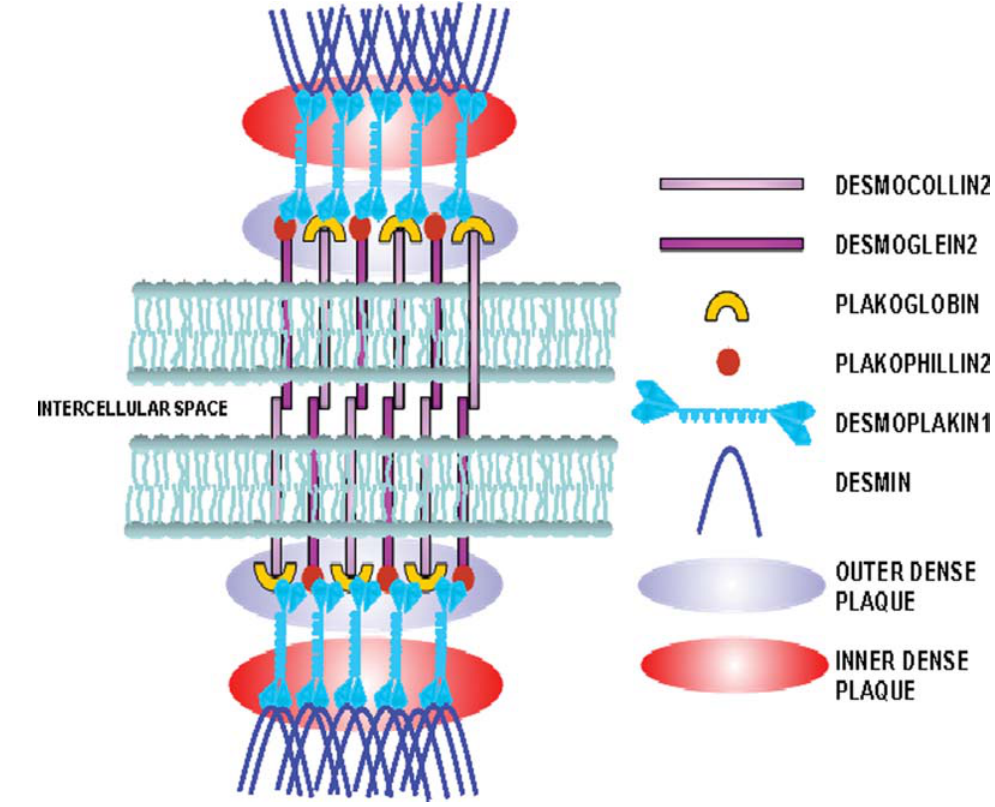
Figure 2. The desmosome consists of three families of proteins: the desmosomal cadherins, desmocollin and desmoglein, members of the armadillo family of proteins, plakoglobin and plakophillin and the plakins.